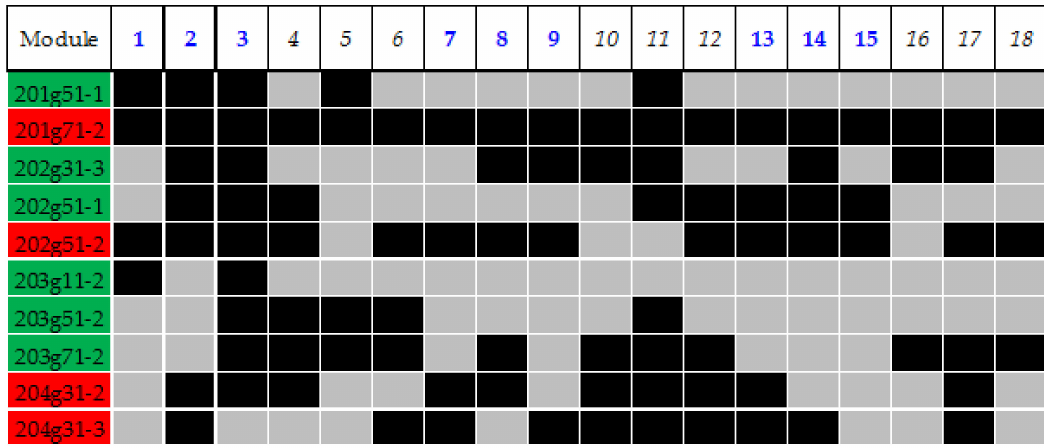
Figure 15. Diagram of the working (grey) and inoperative (black) cells inside the modules before dehumidification.